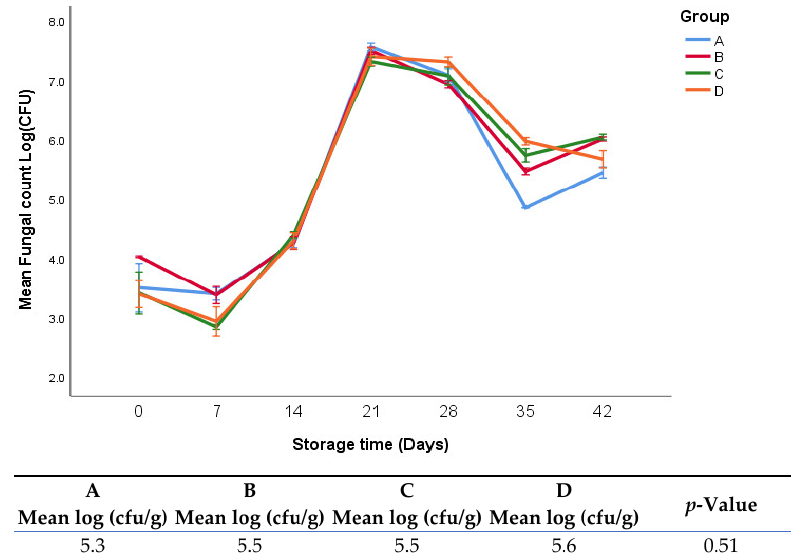
Figure 6. Mold and yeast growth of fresh oregano at refrigerator temperature 4 °C. The significant differences ( p < 0.05) between means are indicated in different letters in the same row. The effect of treatments was pooled to consider the whole storage period and the means were separated by Duncan test.